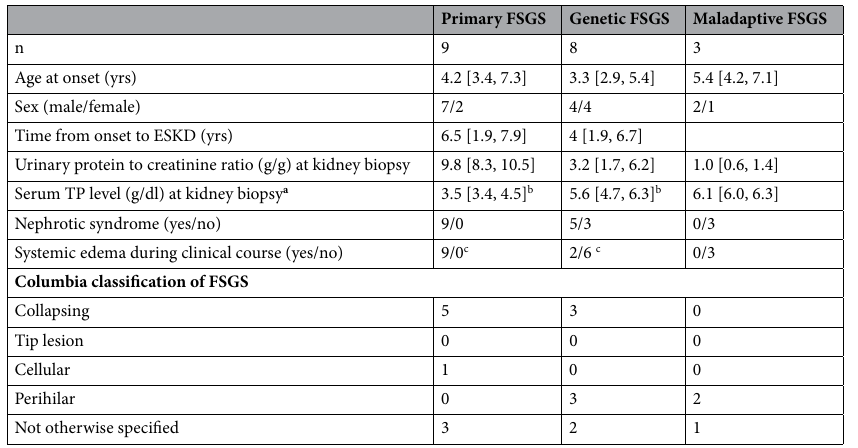
Table 1. Demographics and clinical data of patients. ESKD, end-stage kidney disease; FSGS, focal segmental glomerulosclerosis; TP, total protein. Data was expressed as medians with 25th and 75th percentiles. a Serum total protein level, instead of serum albumin level, was used for the definition of nephrotic syndrome, because some patients in this study were lacking in records of serum albumin levels at native kidney biopsies. b p = 0.0125, c p =